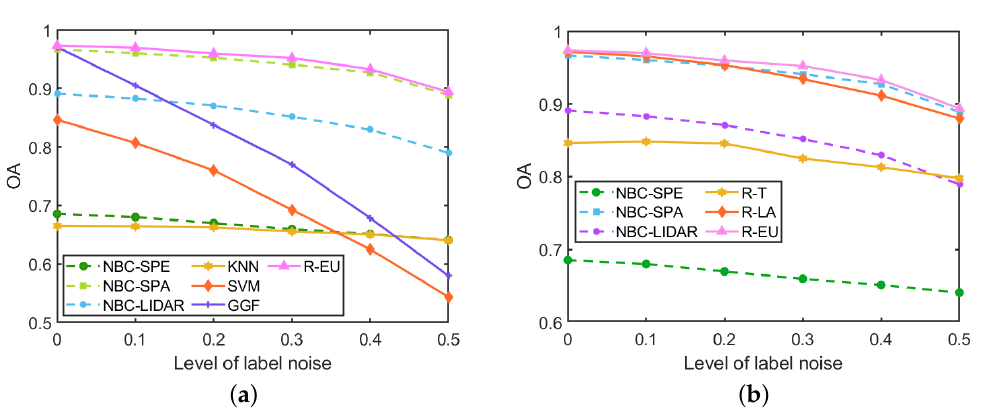
Figure 15. Influence of the label noise on the performance (in terms of OA of different methods) for the GRSS2013 data set. ( a ) R-EU compared with other methods; ( b ) Comparisons among three strategies.